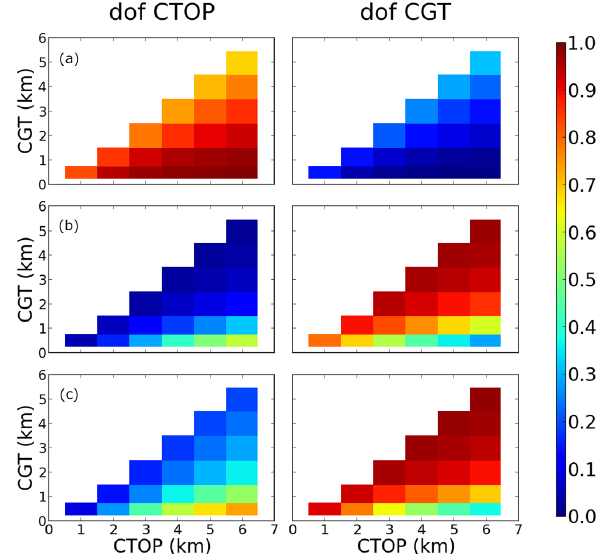
Figure 13. Comparison between mono- and multi-angular A-band ratio with MSPI’s configuration: (a) mono-angular A-band ratio DOF (VZA = 0 ◦ , nadir), (b) same as (a) with a reduced a pri- ori standard deviation on CTOP (0.5km) and (c) same as (b) for multi-angular measurements (orbit/AS 1). COT = 16, r eff = 12µm, v eff = 0.02, SZA = 30 ◦